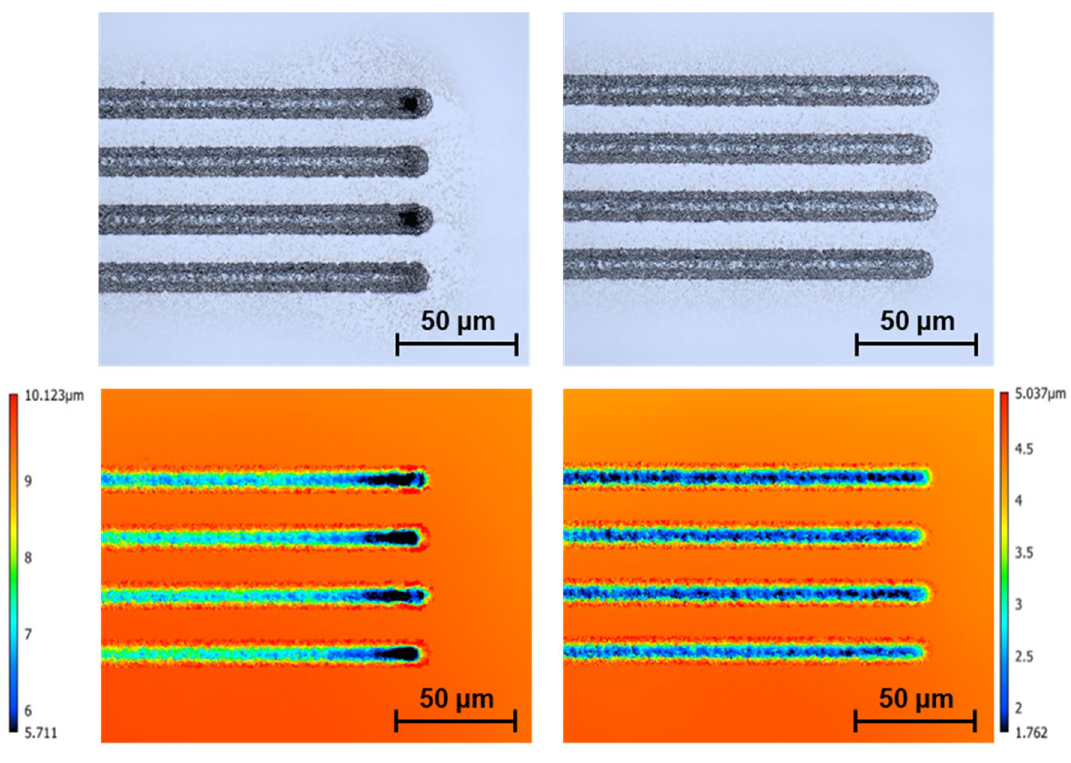
Figure 10. Laser lines drawn on silicon with no dwelling compensation depicting “burn-in” and causing uneven milling at the edges (left), and an example of lasering with dwelling compensation (right).